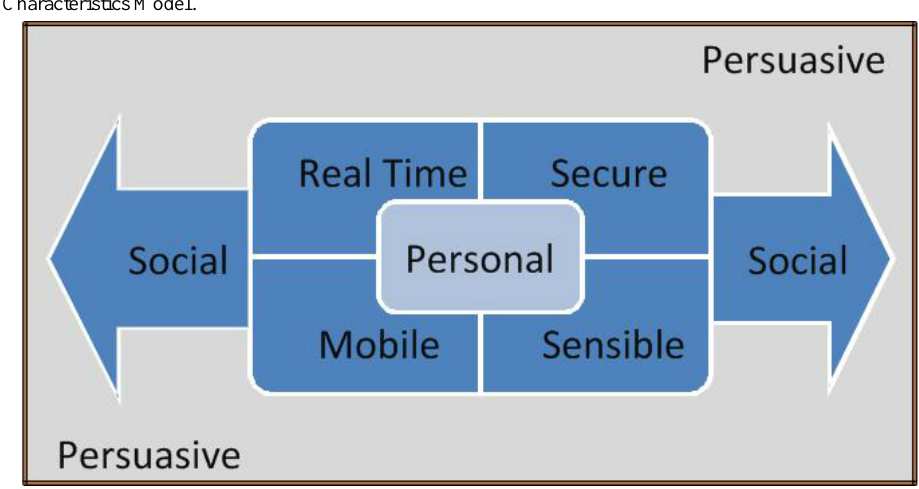
Figure 2. PersonA Characteristics